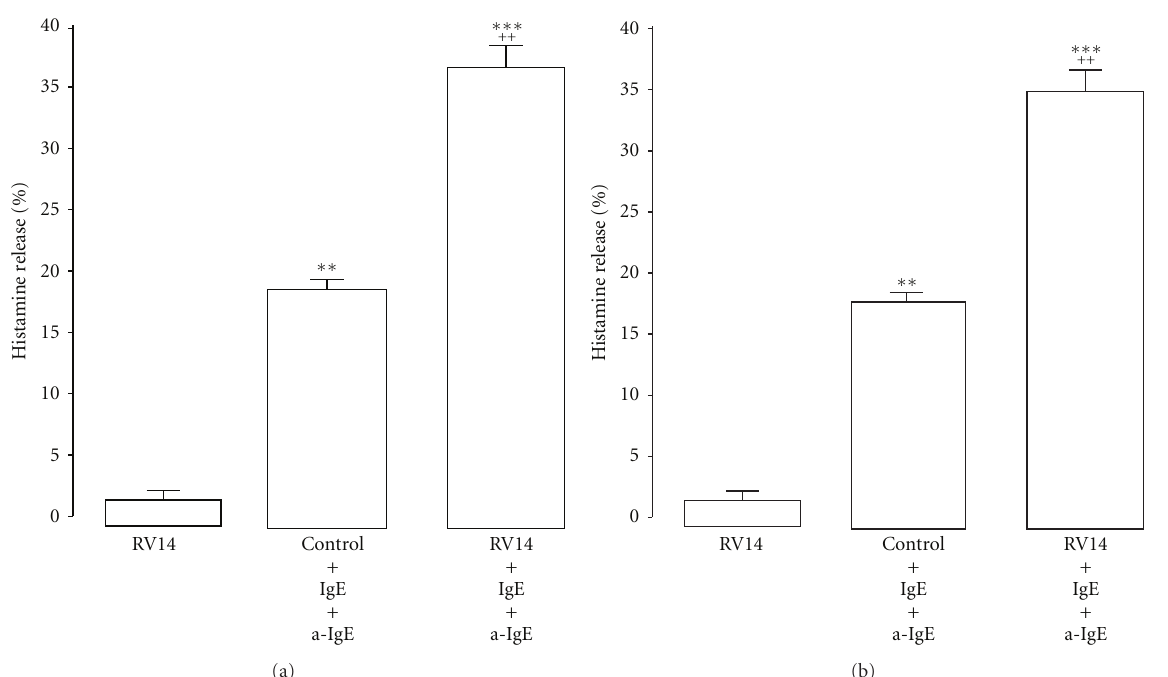
Figure 4: Histamine release into supernatants of the cell lines from human mast cells (HMC-1) (left side) and basophils (KU812) (right side) in the presence of immunoglobulin E (IgE) plus anti-IgE (IgE + a-IgE) after type 14 rhinovirus (RV14) or sham (control) infection. Results are reported as means ± S.E.M. from 7 samples. Significant di ff erences from RV14 infection alone are indicated by ∗∗ P < 0.01 and ∗∗∗ P < 0.001. Significant di ff erences from stimulation with IgE + a-IgE alone are indicated by ++ P < 0.01 (Cited from